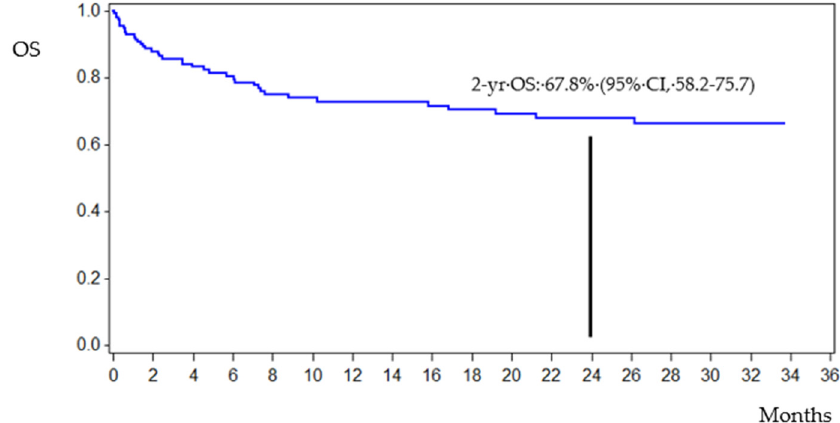
Figure 2. Survival